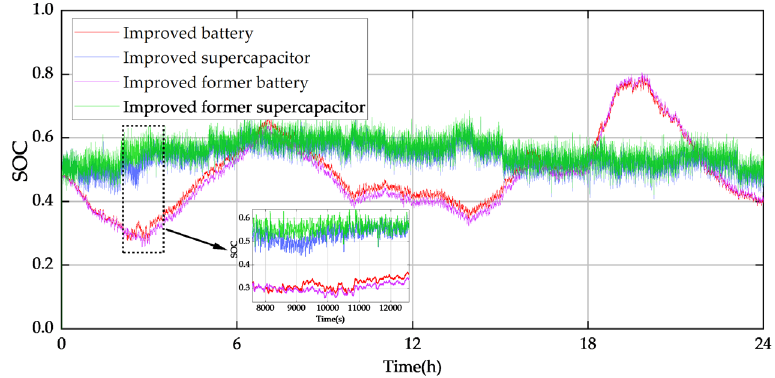
Figure 18. Comparison of SOC changes between lithium battery and super capacitor before and after improvement.